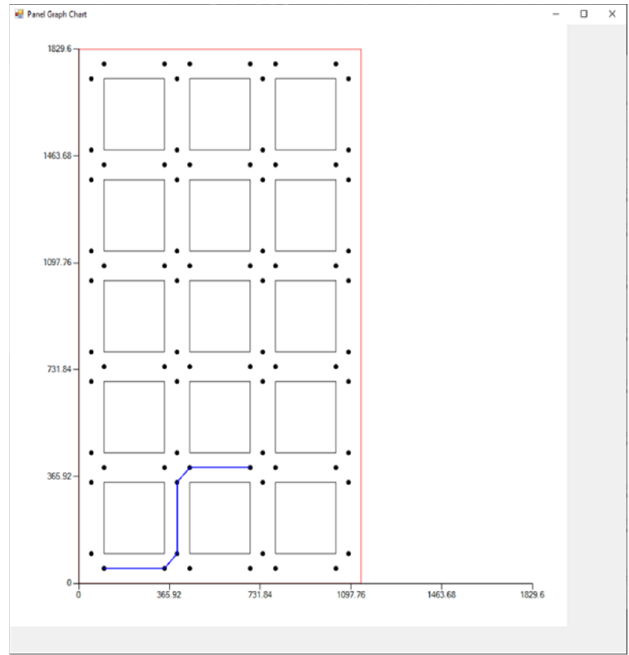
Figure 10. Optimum path finder tool.